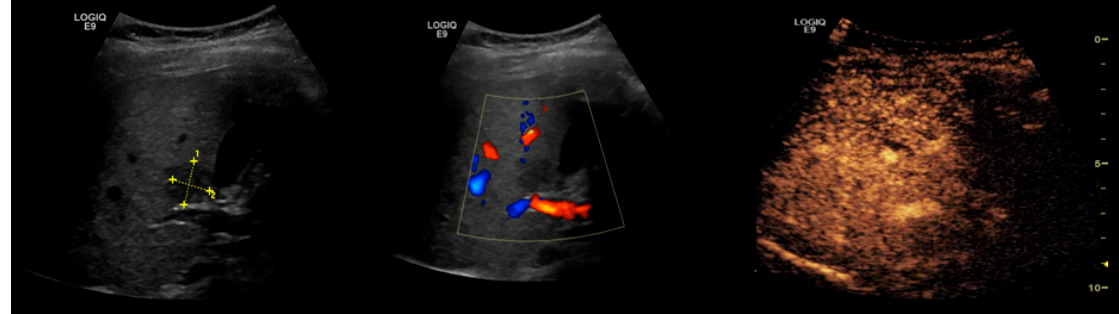
Figure 5. Focal sparing in the pericholecystic region. Hypoechoic image located around the gallbladder in a fatty liver. The Doppler examination cannot reveal any vessels within the lesion. On CEUS, the enhancement was homogeneous during the arterial, portal, and parenchymal phases, without any apparent focal lesions.